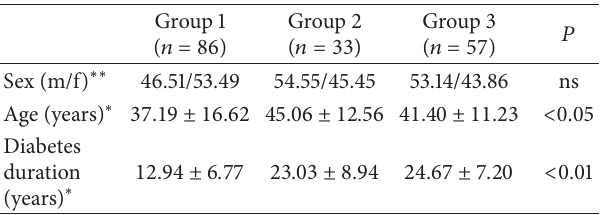
Table 1: Basic characteristics of type 1 diabetic patients ( 𝑛 = 176 ) divided into three groups according to diabetic retinopathy